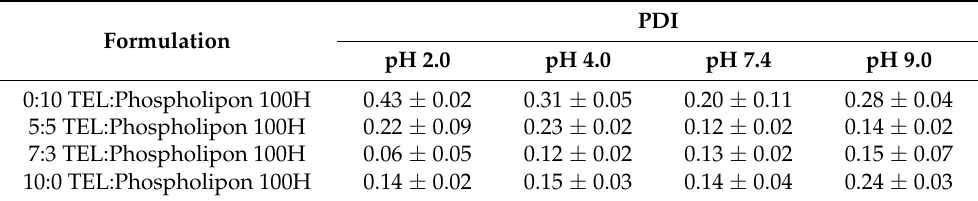
Table 3. The polydispersity index (PDI) of liposomes composed of tetraether lipids (TEL) and Phospholipon 100H (Ph) in different molar ratios (0:10, 5:5, 7:3, 10:0; TEL:Ph) incubated for 4 d at pH 2.0, 4.0, 7.4, and 9.0, respectively.